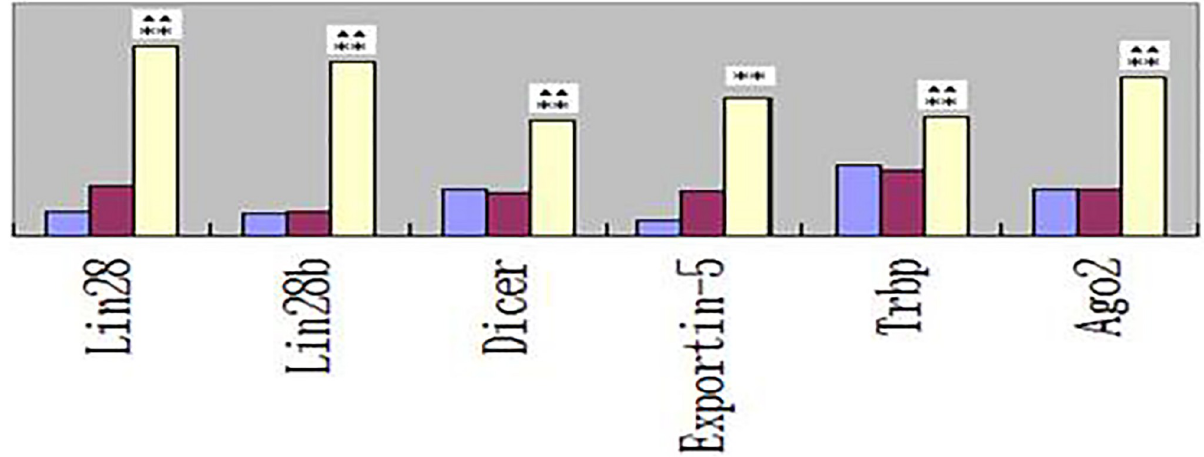
Fig 3. Relative mRNAs levels of selected genes that are important in the miRNA biogenesis pathways and their regulation. Double stars( �� ) and stars( ▲▲ ) are same as Fig 2.